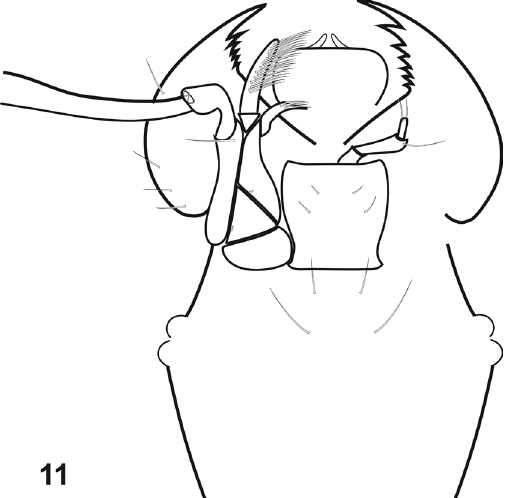
Figure 11. Mouthparts of Prespelea , based on P. myersae . Left maxilla and right labial palpus are omitted for